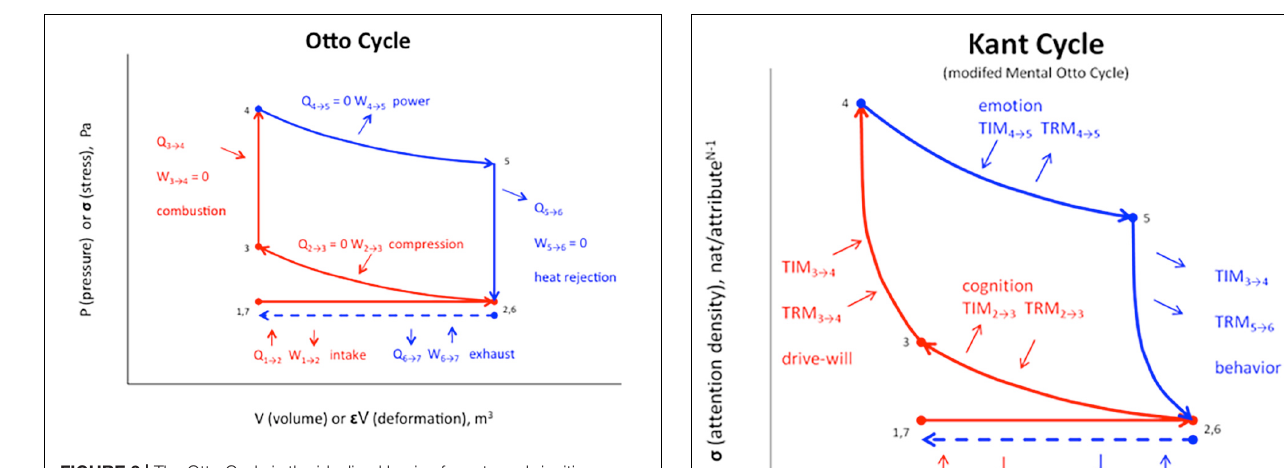
FIGURE 3 | The Otto Cycle is the idealized basis of most spark-ignition gasoline engines. (Intake stroke, 1 → 2) a camshaft opens an intake valve allowing air from the atmosphere and fuel from the reservoir to enter the cylinder. This entering material brings with it the heat Q 1 → 2 and expands system volume by pushing the piston, performing the work W 1 → 2 . (Compression, 2 → 3) the piston performs work W 2 → 3 on the system by compressing it along an adiabat ( Q 2 → 3 = 0). (Combustion, 3 → 4) the spark plug ignites the fuel/air mixture releasing great heat Q 3 → 4 into the gas. Since the heat is generated more quickly than the piston can follow, no work is done during combustion ( W 2 → 4 = 0). (Power 4 → 5) at high temperature, a good deal of work W 4 → 5 is done as the gas expands, pushing back the piston. Ideally, there is no heat loss ( Q 4 → 5 = 0). During heat rejection (5 → 6), heat Q 5 → 6 is lost as the temperature drops, but no work is done ( W 5 → 6 = 0). On the final stroke (exhaust, 6 → 7), the piston does work W 6 → 7 on the system, expelling the products of combustion and any unburned air and fuel, along with heat Q 7 → 7 . Cycle, in any case, serves as a good heuristic since it is analogous